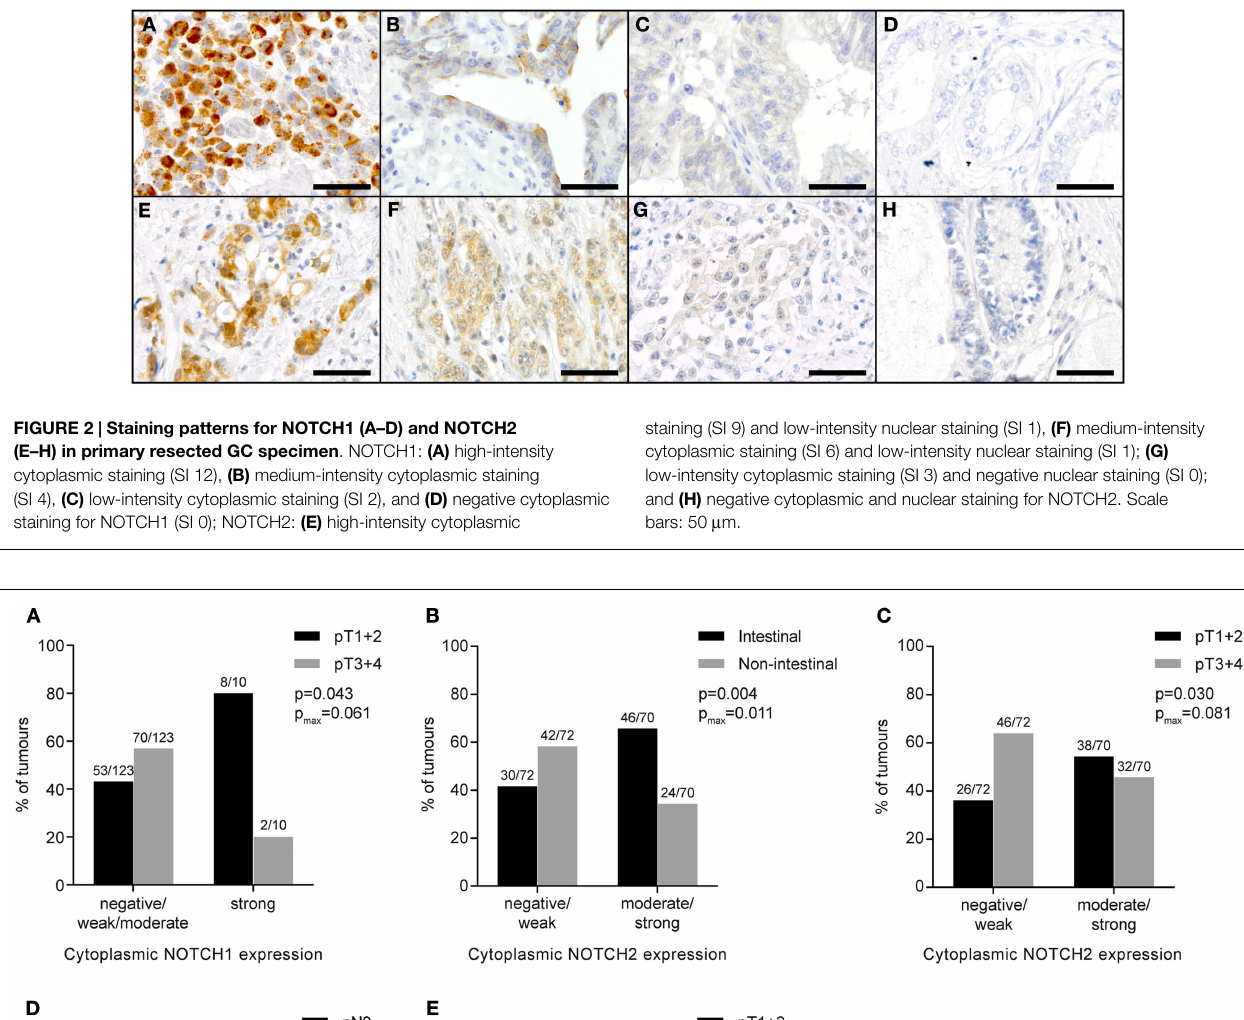
FIGURE 3 | Association of NOTCH1 or NOTCH2 protein expression with clinico-pathological features of primary resected gastric carcinomas . Numbers above the bars indicate the absolute number of cases. p -Values were determined by the χ 2 -test or Fisher’s exact test; p max corresponds to p -values for maximally selected statistics. (A) Cytoplasmic NOTCH1 expression and